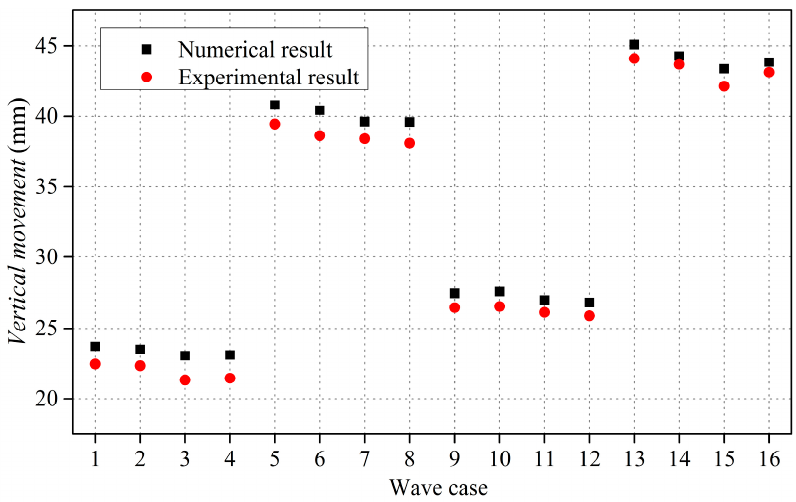
Figure 10. The comparison of vertical movement of the net between the numerical and experiment results.